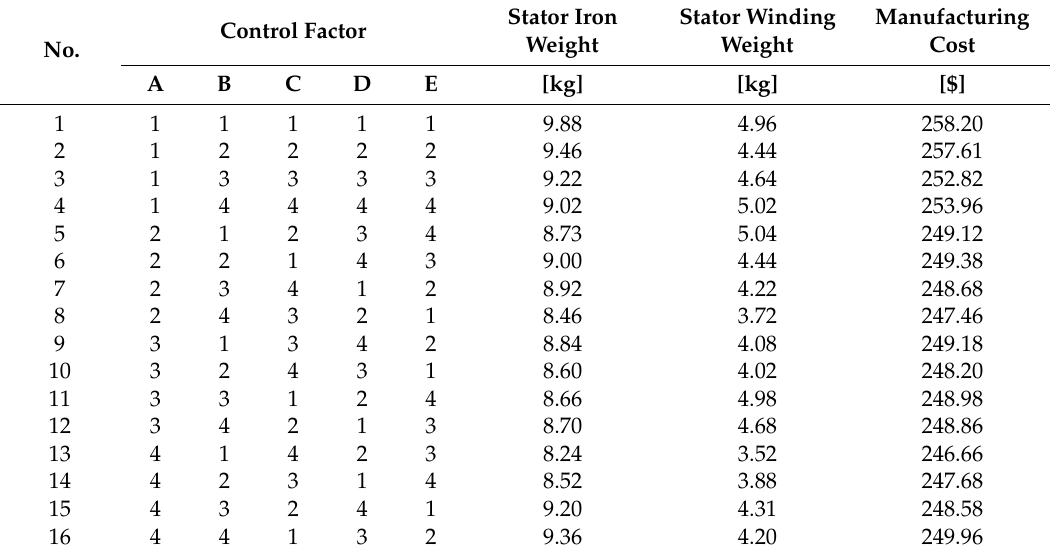
Table 4. Orthogonal array (OA) L16 matrix by using Taguchi method and experimental results.